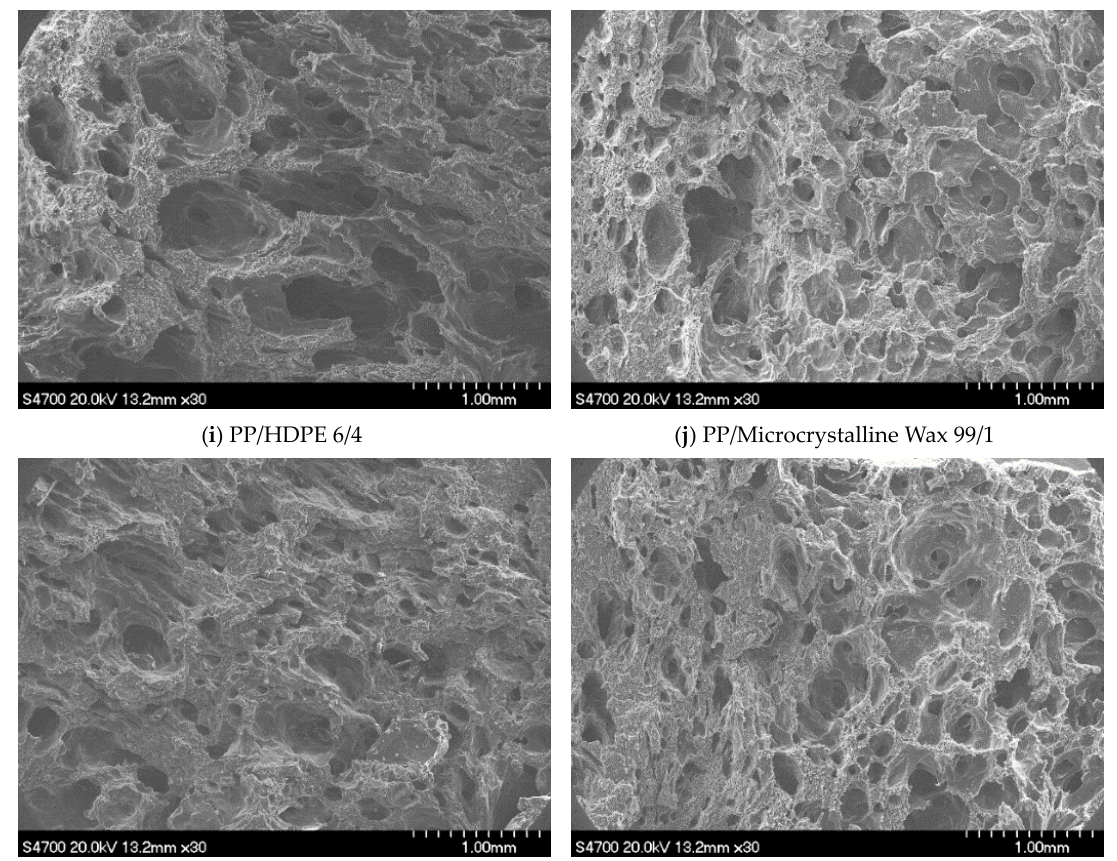
Figure 4. Cell morphology of the foaming samples with different polymer blends: ( a ) sample 1, ( b ) sample 2, ( c ) sample 3, ( d ) sample 4, ( e ) sample 5, ( f ) sample 6, ( g ) sample 7, ( h ) sample 8, ( i ) sample 9, ( j ) sample 10, ( k ) sample 11, ( l ) sample 12.